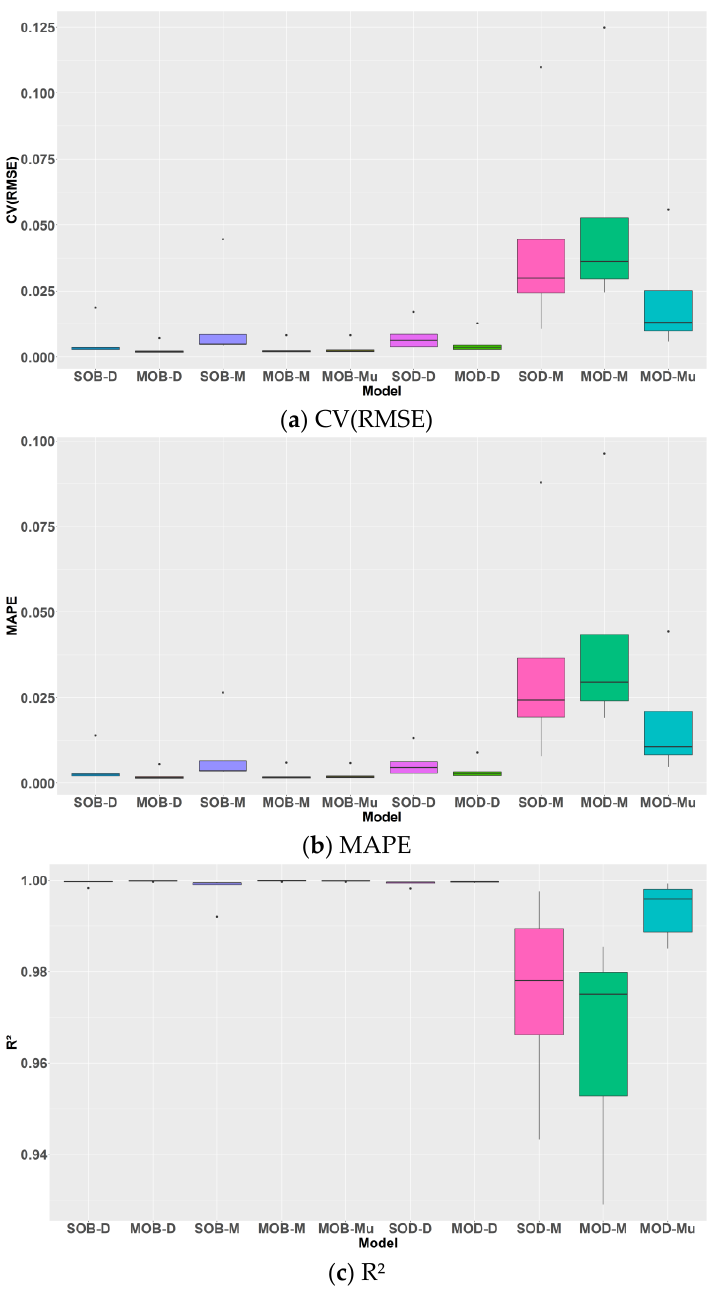
Figure 19. Performance of 10 models for monthly heating energy (refer to Table 4 for model explanation).